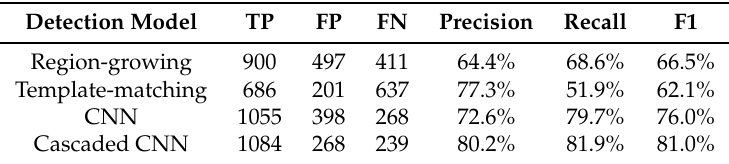
Table 4. The comparisons of the all areas.